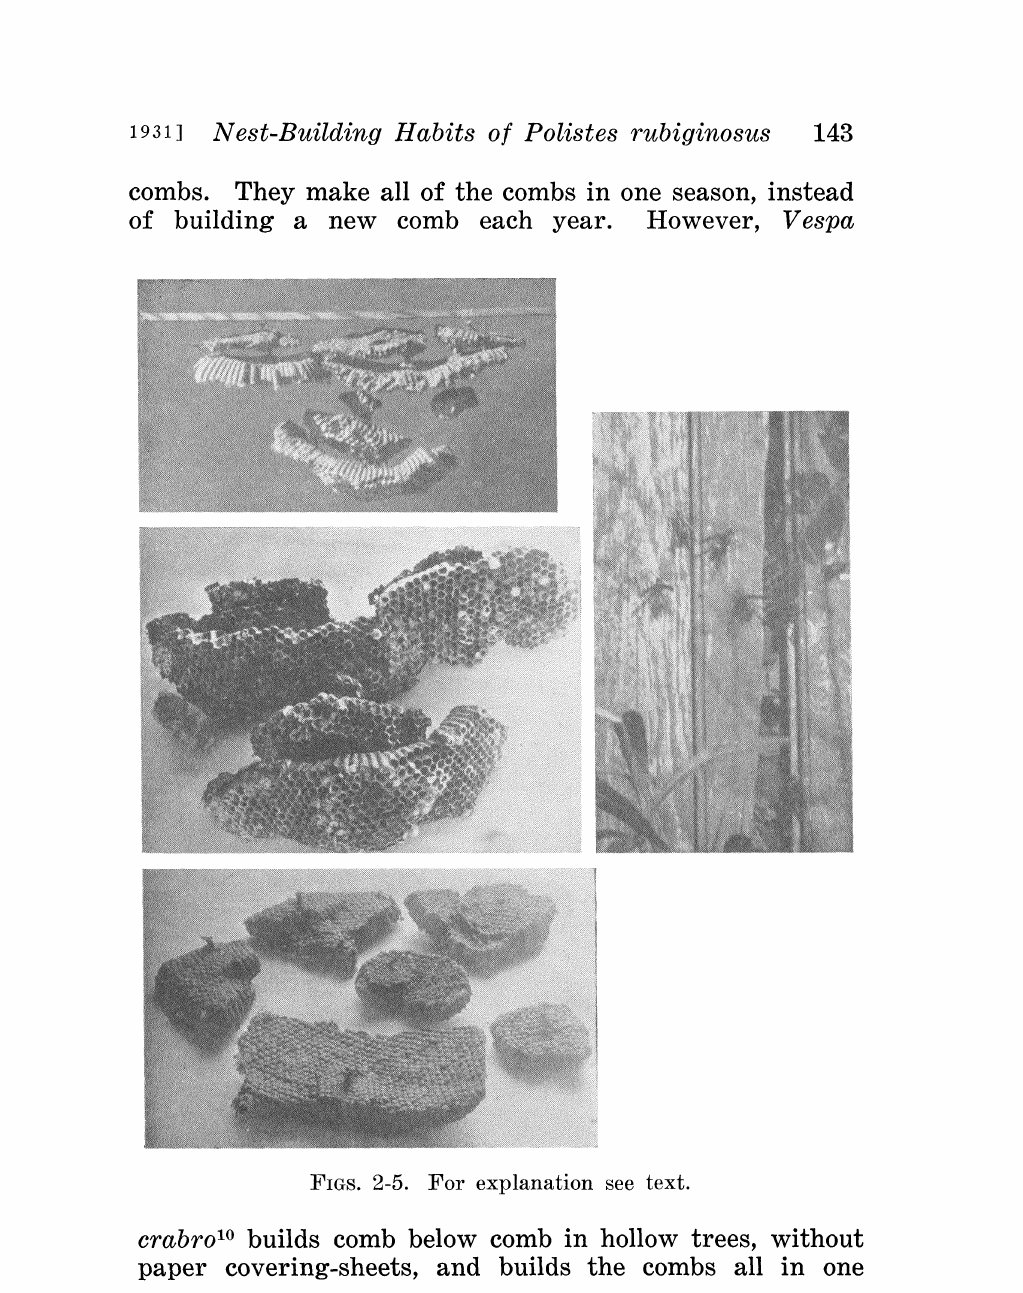
FIGS. 2-5. For explanation see